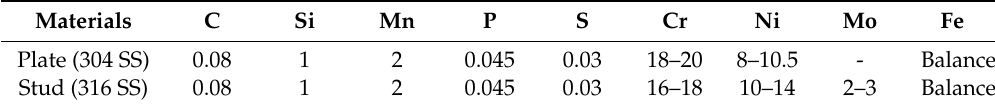
Table 1. Composition (wt %) of stud and base metal utilized in this study.